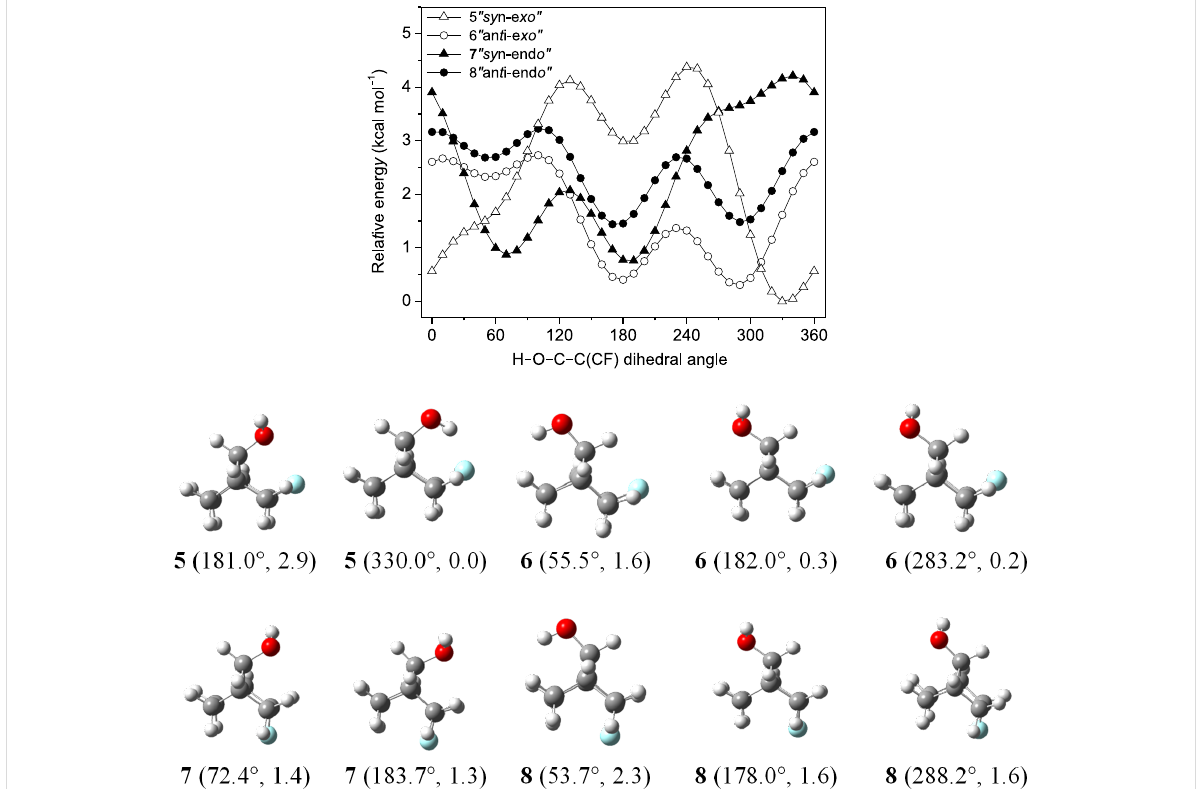
Figure 2: Potential energy surfaces for the diastereoisomers of 2-fluorobicyclo[2.2.1]heptan-7-ols ( 5 – 8 ), obtained at the HF/6-31g(d,p) level, and the optimized minima at the MP2/aug-cc-pVDZ level ( θ dihedral angles and relative energies, in kcal mol − 1 , in parenthesis).